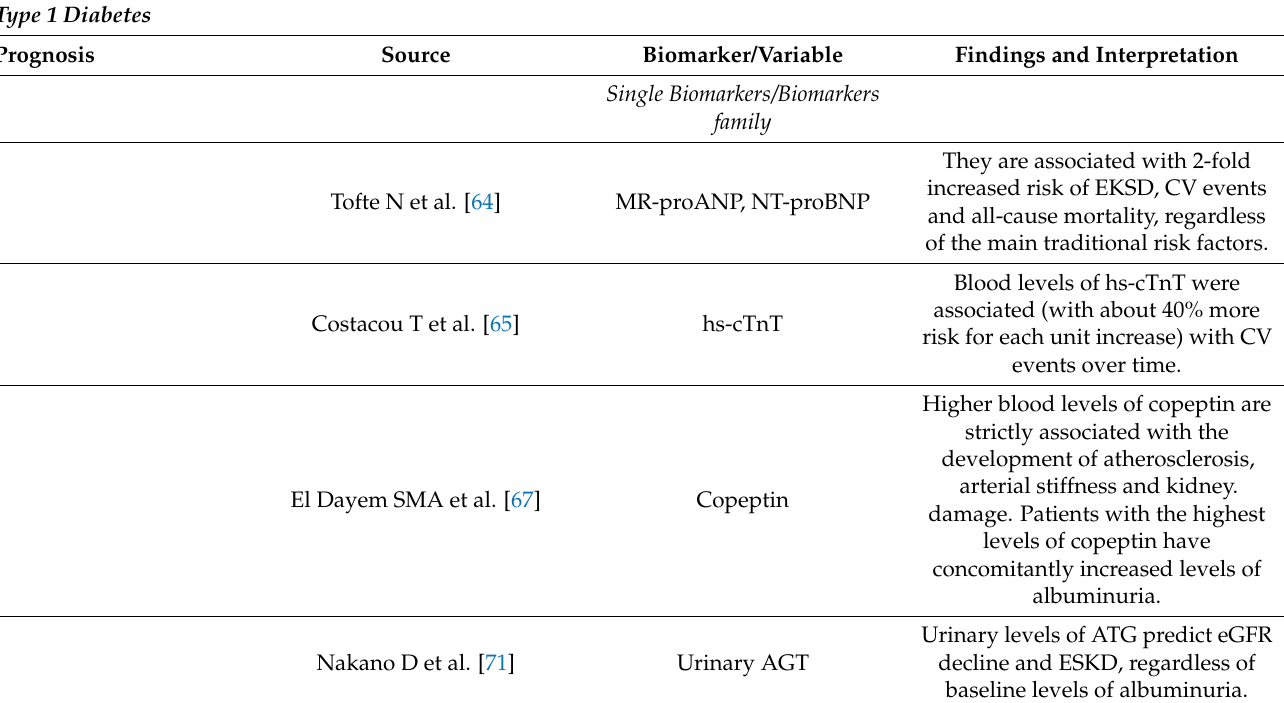
Table 1. Prognostic and treatment response biomarkers in DKD